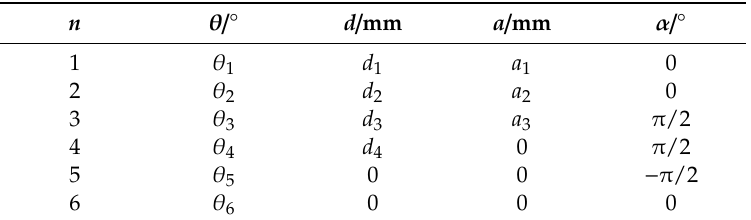
Table 1. Counter-example of Pieper Criterion 1